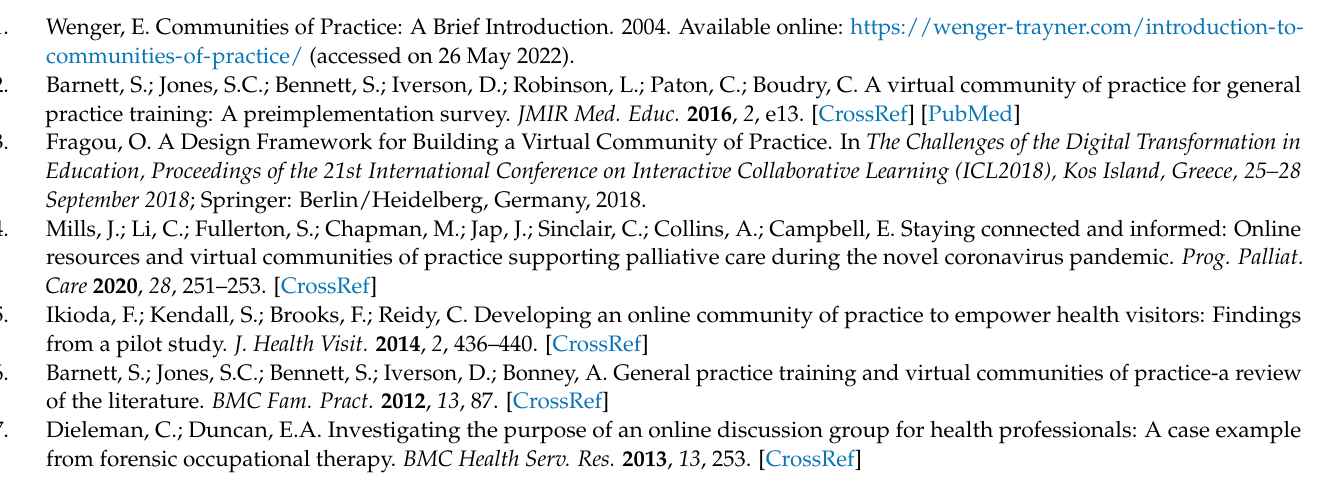
papers; Table S2: Table of study characteristics case reports; Table S3: Table of study characteristics: Other types of study; Table S4: Table of VCoP processes; Table S5: Table of VCoP roles; Table S6: PRISMA-ScR